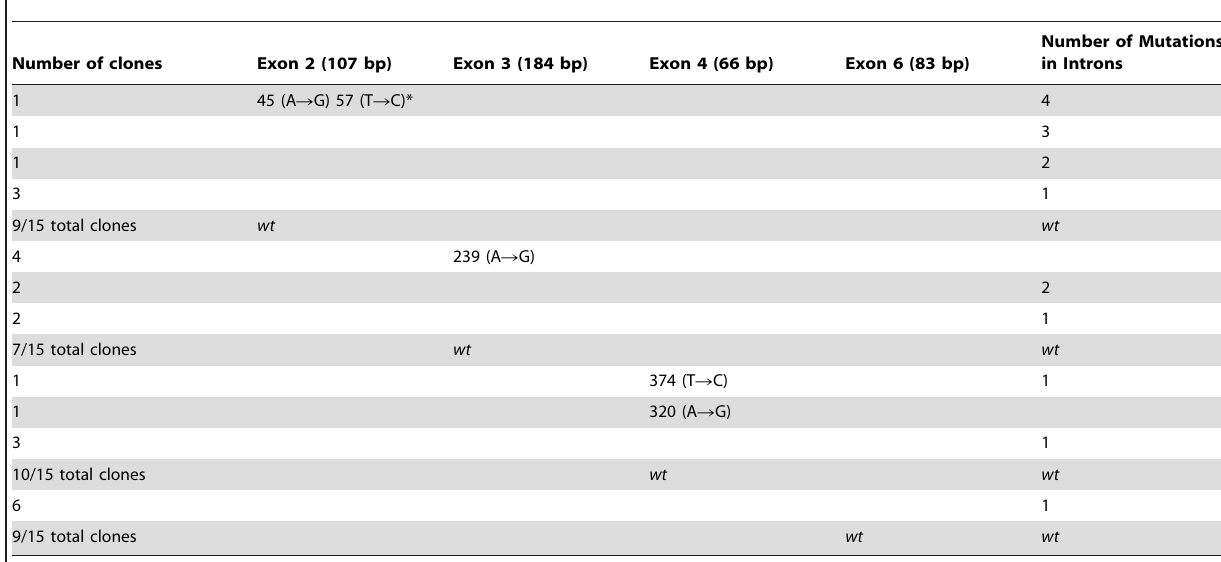
Numeration of nucleotide positions of exons starts from A of the initial ATG triplet of the coding sequence. *, mutation already identified in cDNA samples from tumour tissues of patient B. wt : wild type sequence.